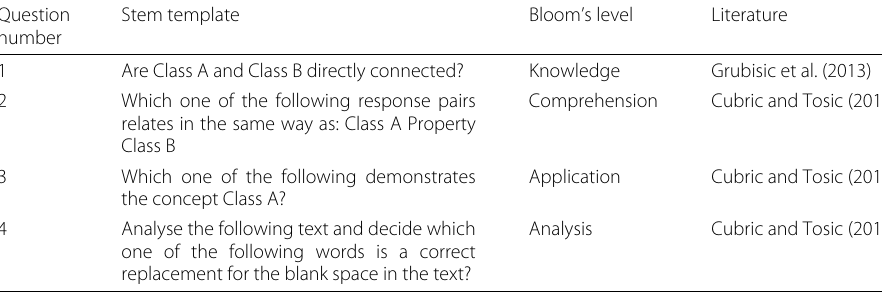
Table 4 Part of the stem templates analysed in the experiment